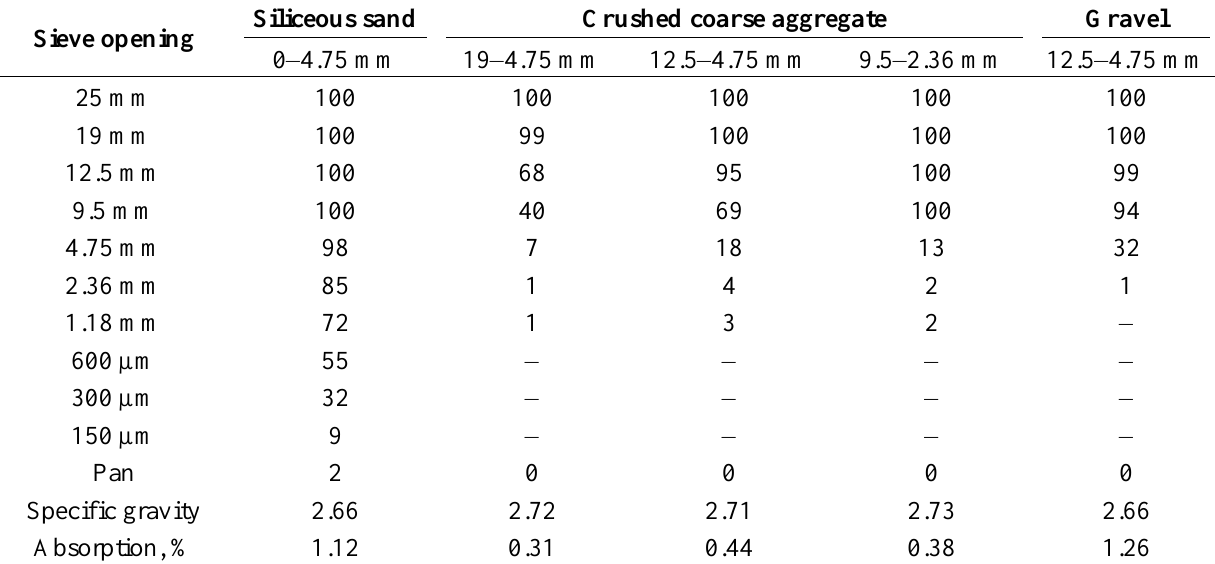
Table 3. Grading and properties of coarse aggregate and